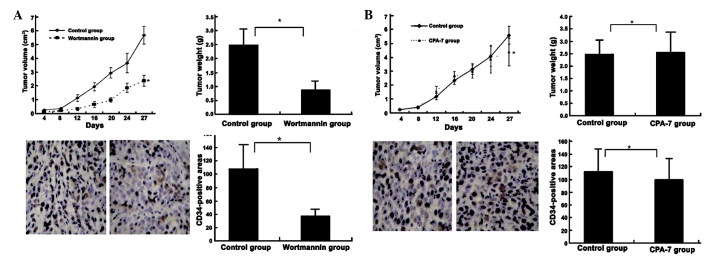
Blocking Akt but not STAT3 inhibits tumor growth and angiogenesis. (A) Targeting Akt in human tumors inhibited tumor growth and was accompanied by a reduction in tumor angiogenesis (CD34-positive areas). Nude mice bearing subcutaneous NCI-H446 tumors were treated with Akt inhibitor wortmannin at 3 mg/kg twice weekly. Compared with that in the control group, tumor growth in the wortmannin group was significantly decreased. Following sacrification of mice 30 days after inoculation, tumor weight was significantly decreased in the wortmannin group compared with that in the control group. Immunohistochemical analysis showed that CD34-positive areas were also significantly decreased in the wortmannin group as compared with those in the control group (wortmannin group vs. control group, *P<0.05). (B) Inhibition of STAT3 in human tumors exhibited no significant inhibitory effect on tumor growth and angiogenesis. Nude mice bearing subcutaneous NCI-H446 tumors were treated with STAT3 inhibitor CPA-7, at 5 mg/kg twice weekly, which did not significantly affect tumor volume, weight and CD34-positive areas (CPA-7 group vs. control group, #P>0.05). Values are expressed as the mean ± standard deviation. STAT3, signal transducer and activator of transcription 3.